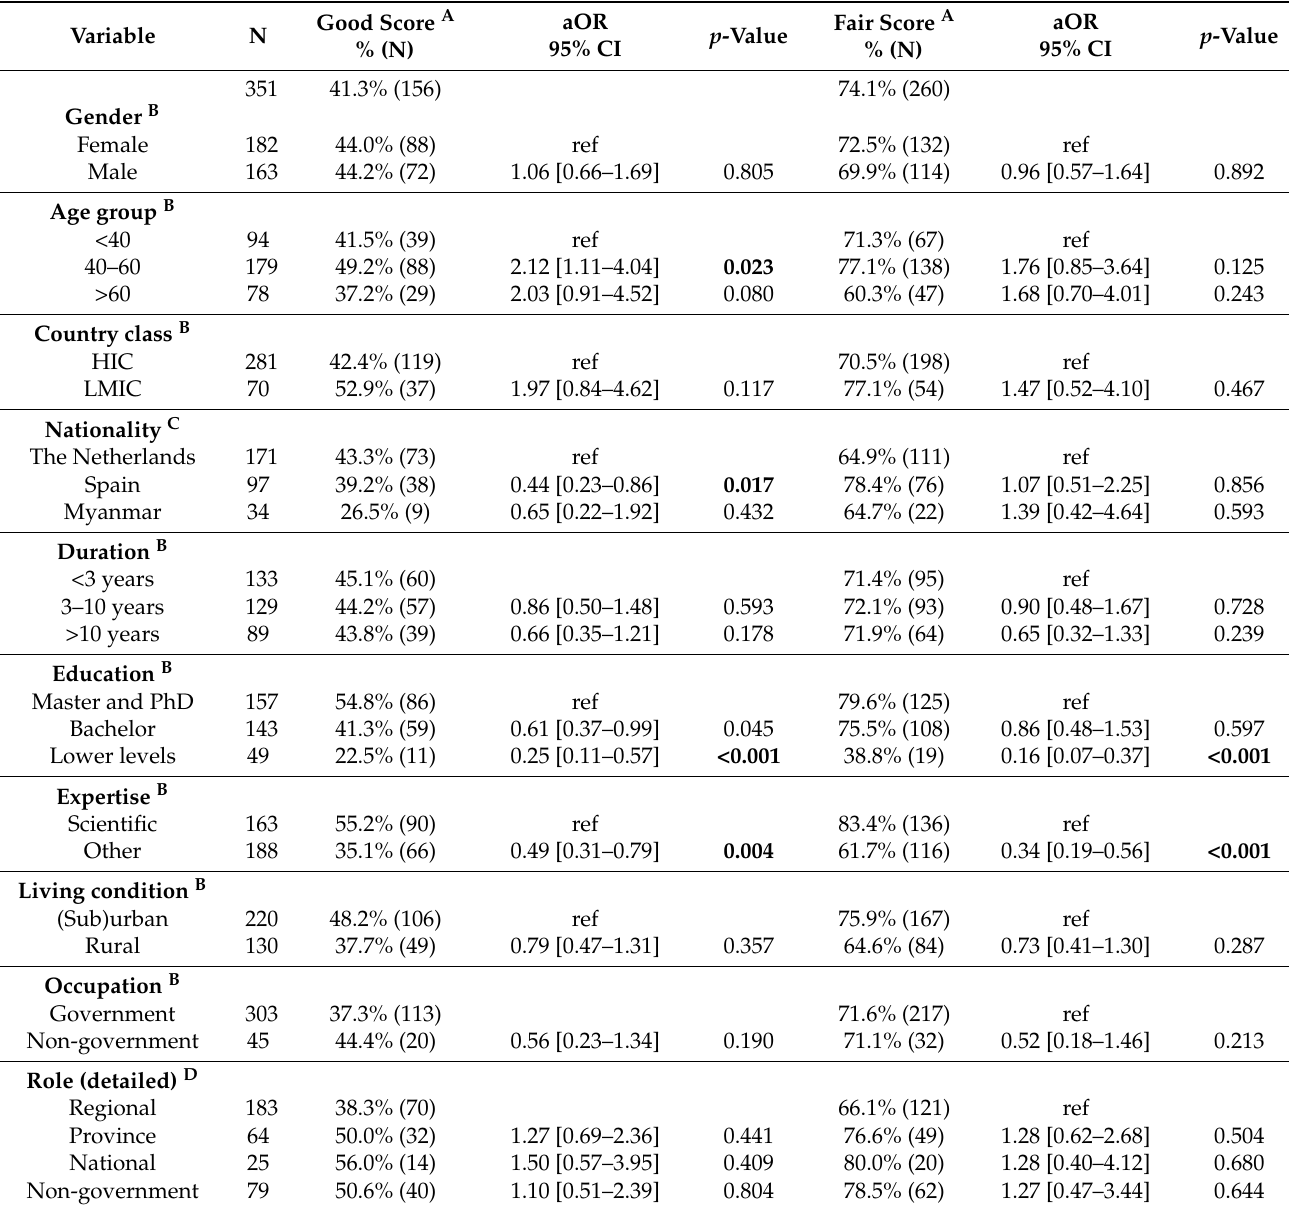
Table 3. Multivariate logistic regression (adjusted odds ratio, aOR) of good and fair knowledge and demographic